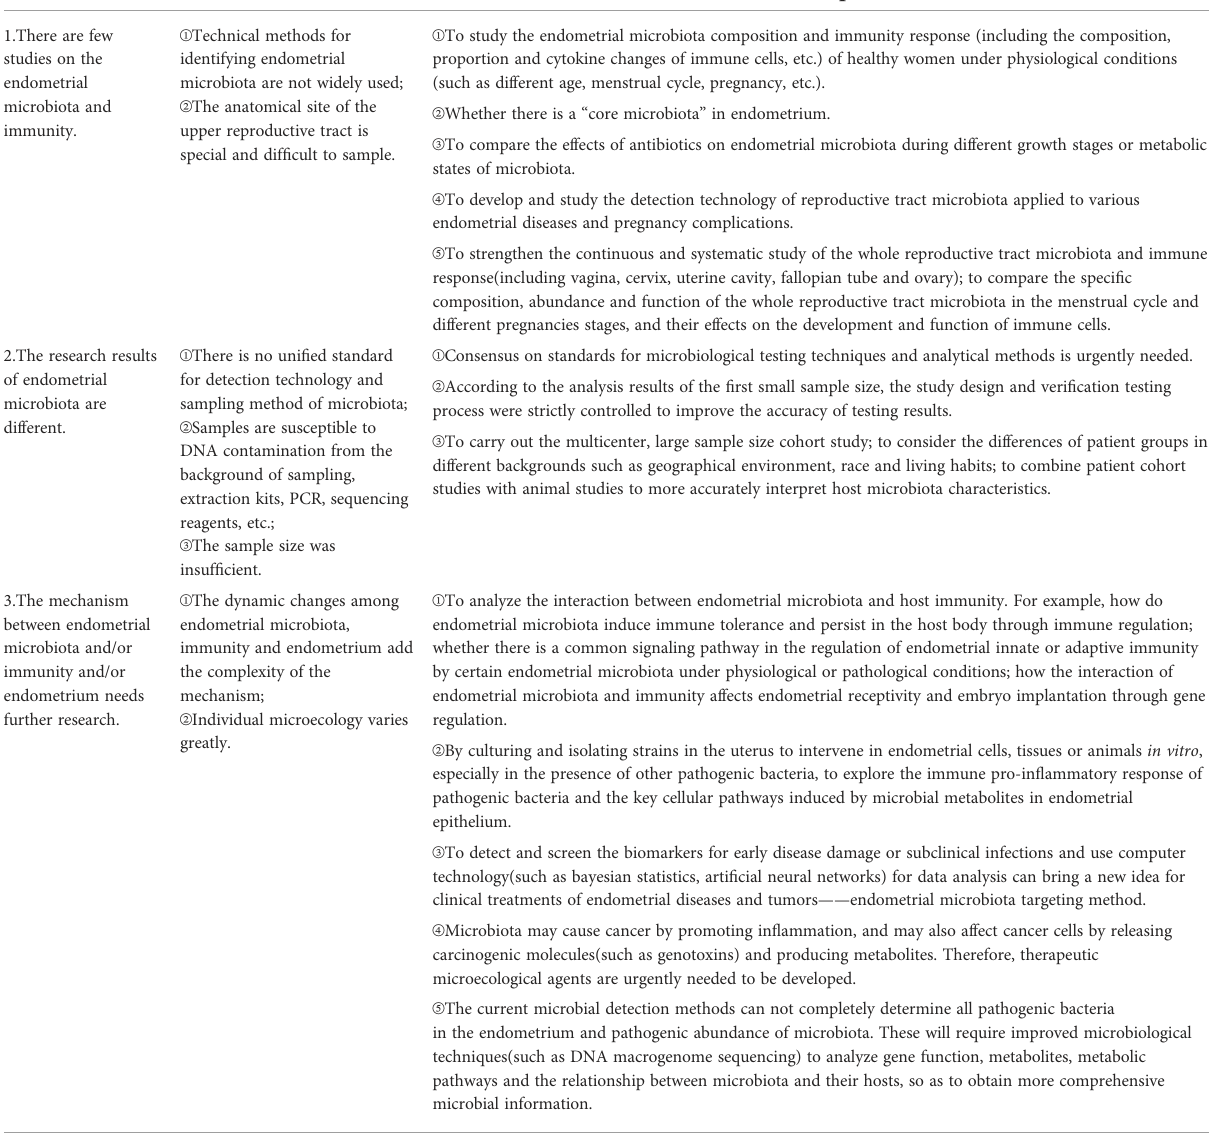
TABLE 2 Current research limitations and future